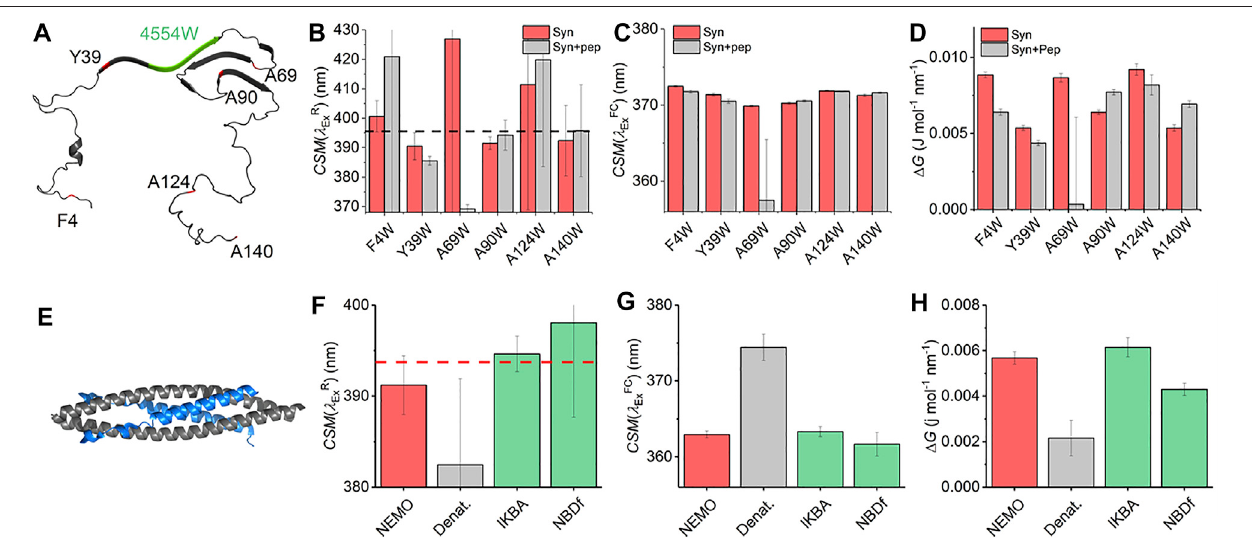
FIGURE4| SingleTrpproteinREES. (A) Structuralmodelof α -synuclein(PDB2n0A24). (B – D) Variationin CSM ( λ R ex ) (B) , CSM ( λ FC ex ) (C) ,and Δ G (D) extractedfrom fi ts of raw REES data to Eq. (7) for α -synuclein (red bars) and in the presence of the therapeutic peptide (gray bars). The black dashed line in (B) shows the CSM ( λ R value extracted where all data are fi t to Eq. (7) with CSM ( λ R ex ) as a shared parameter. (E) Structural model of the N-terminus of NEMO (PDB 3brv) in complex with a peptide representing IKK β (blue). Conditions, 5 µM α -synuclein, 50 mM Tris – HCl, pH 8.0. (F – H) Variation in CSM ( λ R ex ) (B) , CSM ( λ FC ex ) (C) , and Δ G (D) extracted from fi tsofrawREESdatato Eq.(7) forNEMO(redbars),underdenaturingconditions(graybars)andinthepresenceofligands(greenbars).Thereddashedlineinpanel (F) shows the CSM ( λ R ex ) value extracted where all data are fi t to Eq. (7) with CSM ( λ R ex ) as ashared parameter. Raw NEMO REES dataas previously reported inRef. 28.